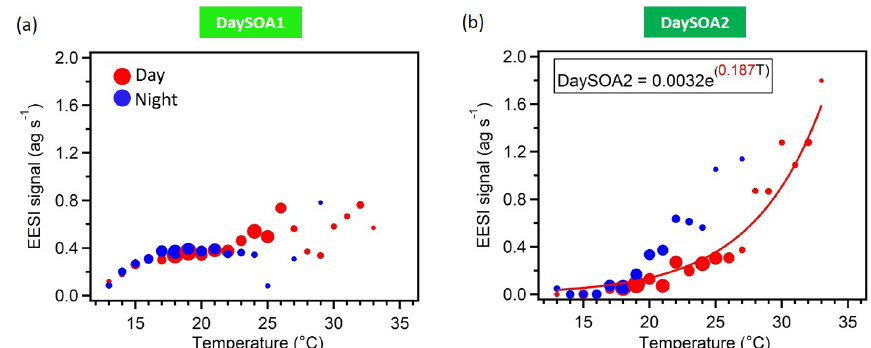
Figure 6. DaySOA1 EESI (a) and DaySOA2 EESI (b) correlation with hourly ambient temperature ( ◦ C). The data are colour-coded according to day (06:00–21:00LT, red) and night (21:00–06:00LT, blue) measurement times, they are grouped in temperature bins of 1 ◦ C, and the size of the dots corresponds to the number of points considered. Data recorded during precipitation events are discarded. The fitting curve is weighted by 1 SD (standard